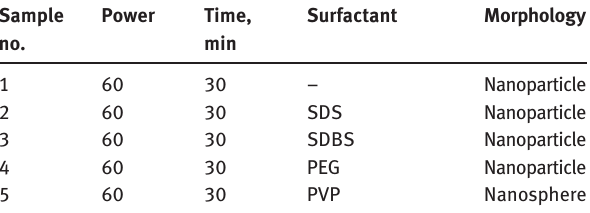
Table 1: Reaction conditions for preparation of HgSe nanoparticles